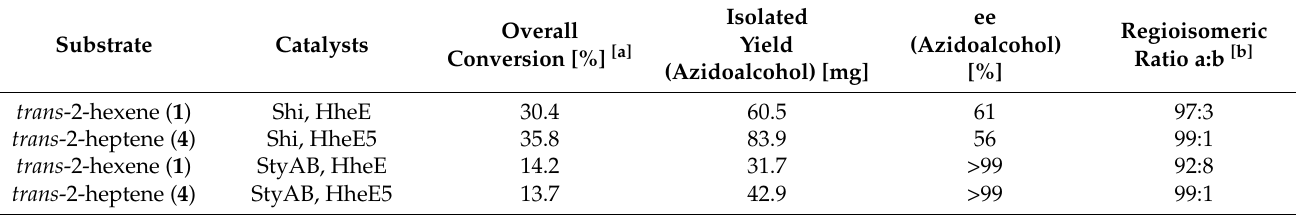
Table 2. Summary of the cascade runs combining StyAB or the Shi epoxidation diketal catalyst with an HHDH (HheE or HheE5). Cascades starting from 50 mM trans -2-hexene ( 1 ) resulted in the formation of 2-azido-3-hydroxyhexane ( 3a ), whereas cascades starting from 50 mM trans -2-heptene ( 4 ) produced 2-azido-3-hydroxyheptane ( 6a ).